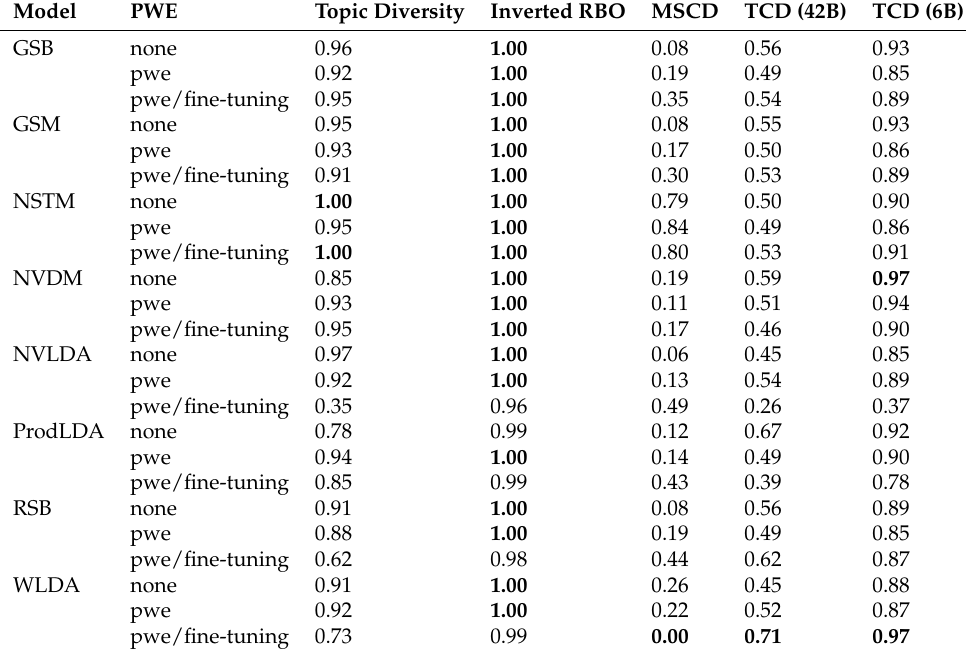
Table 15. Topic Diversity on